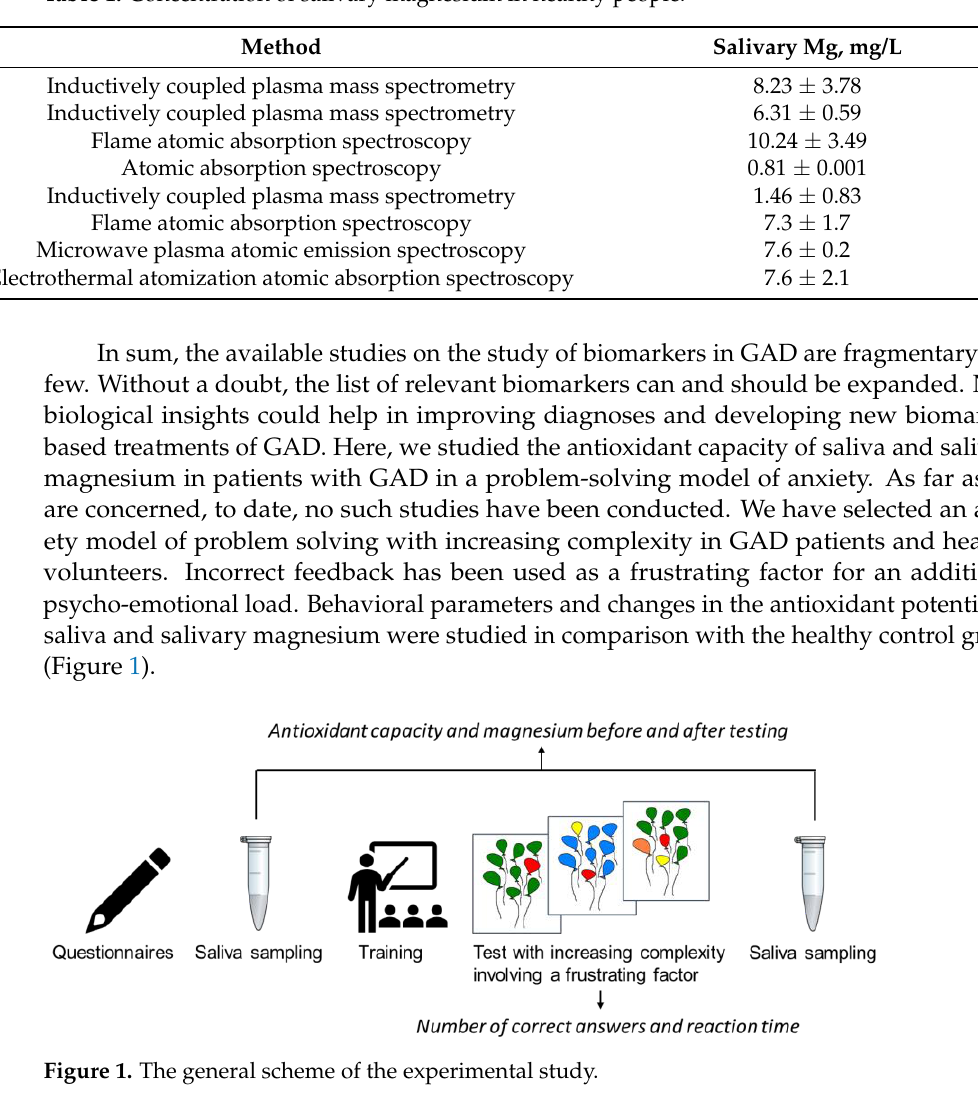
Table 1. Concentration of salivary magnesium in healthy people.